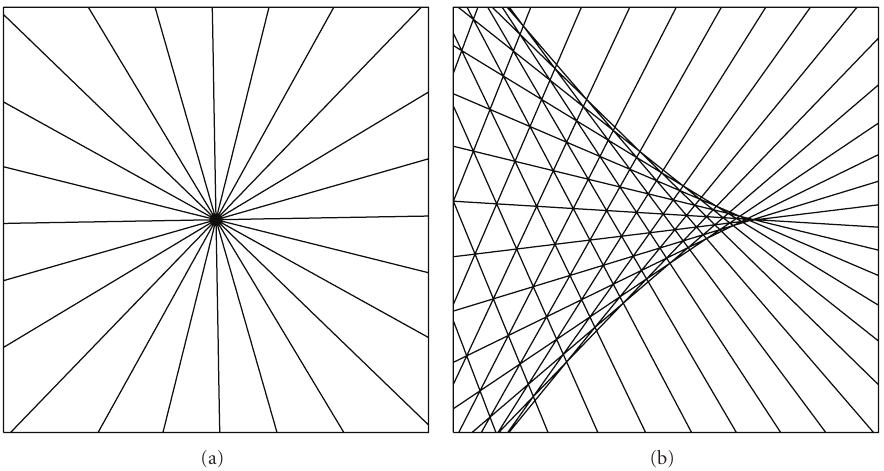
Figure 2: Dark matter trajectories. (a) shows purely radial orbits, while (b) shows particles with angular momentum.